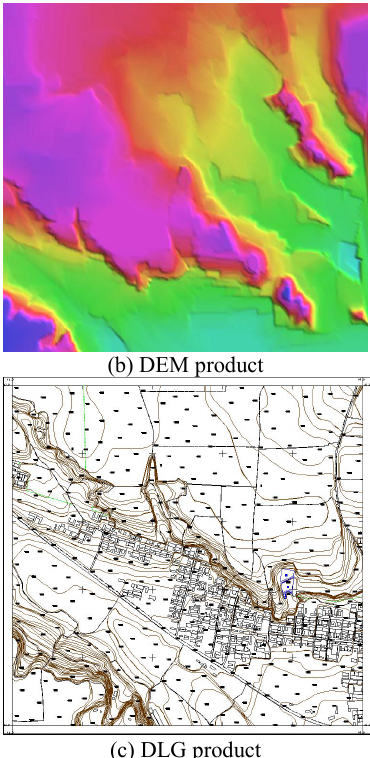
Figure 8. The extraction result of coastal zone of Hailing island In addition, other type of land cover, e.g., coastal farms, was also extracted in similar way, as shown in Figure 9.